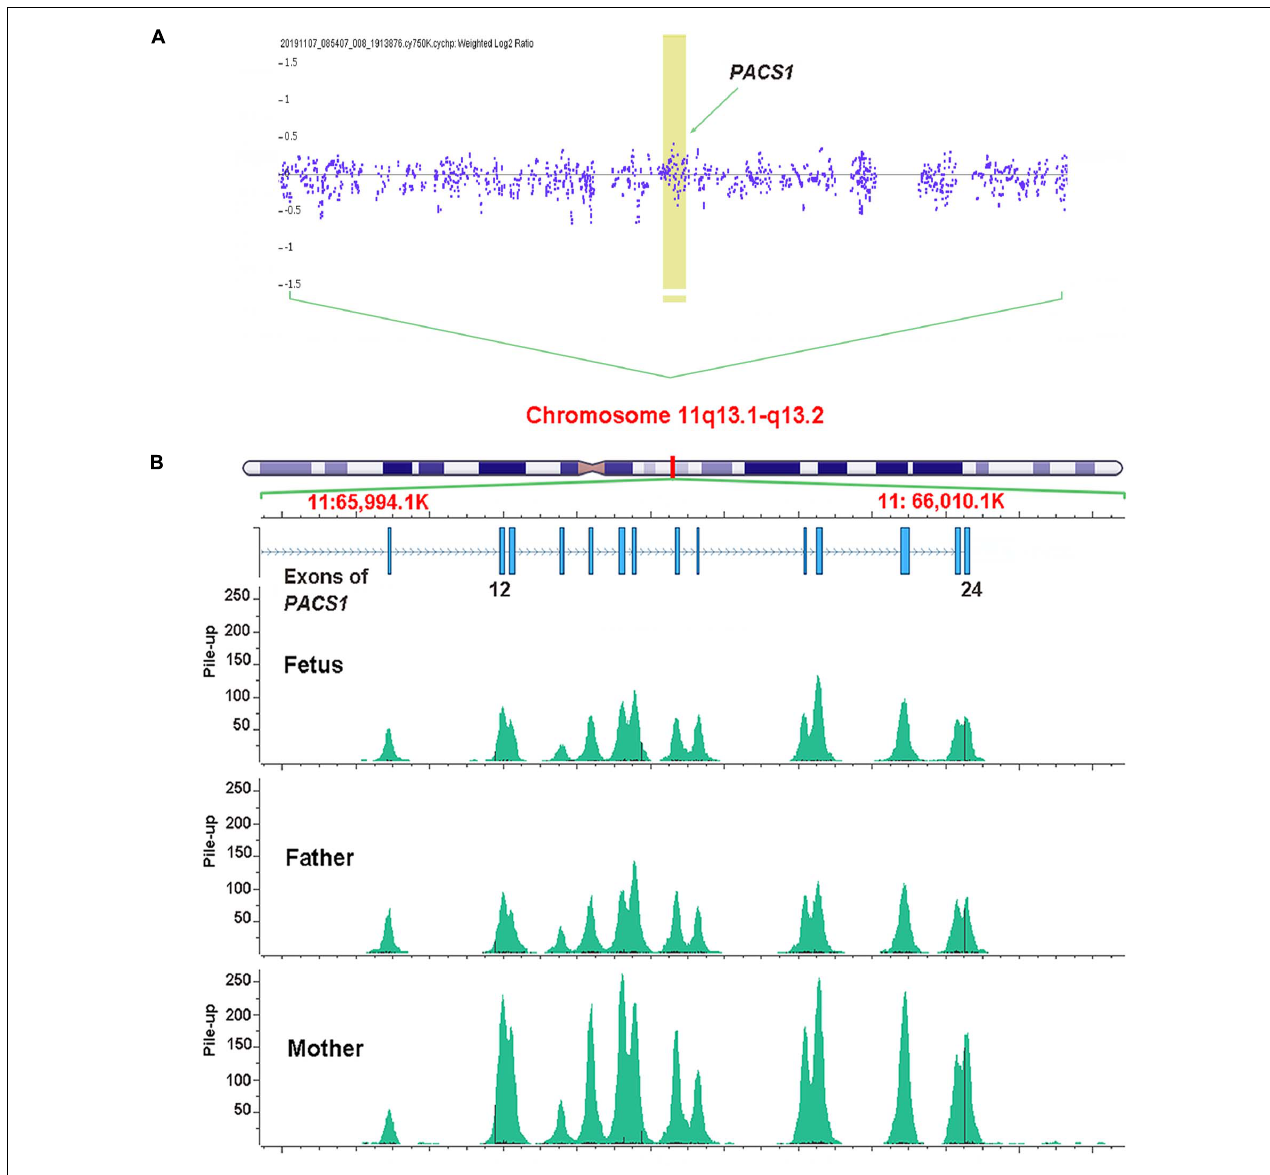
FIGURE 1 | Genomic DNA extracted from chorionic villus tissue was used for single-nucleotide polymorphism array analysis. No micro-duplication or deletion was detected on the region of chromosome 11q3.1–11q3.2. The arrow indicates the sites of PACS1 (A) . Whole-exome sequencing identified a multi-exon deletion (EX12_24del) in PACS1 which was located on chromosome 11q13. The picture of pile-up reads overlapping the sites was generated by Golden Helix Genome Browse. The fetus and the father showed about half pile-up reads to that of the mother that indicated a heterozygous deletion among this region (B)